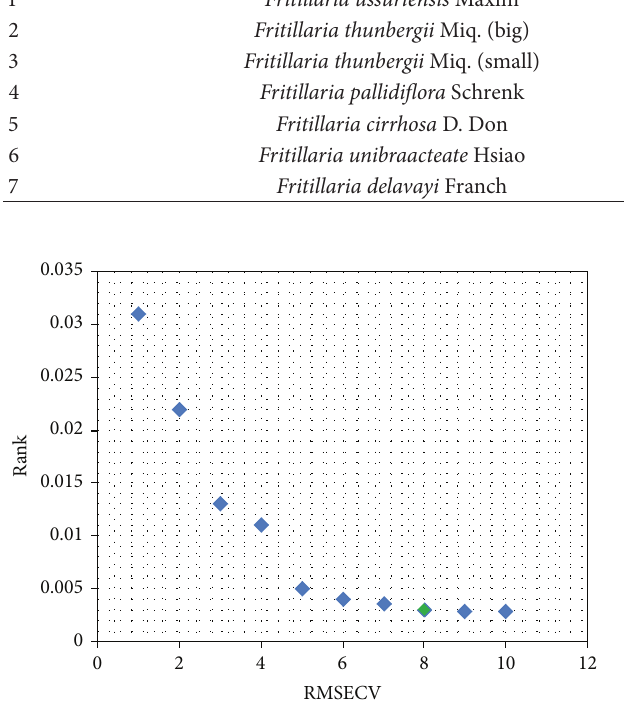
Figure 4: Determination of optimal PLS components by cross